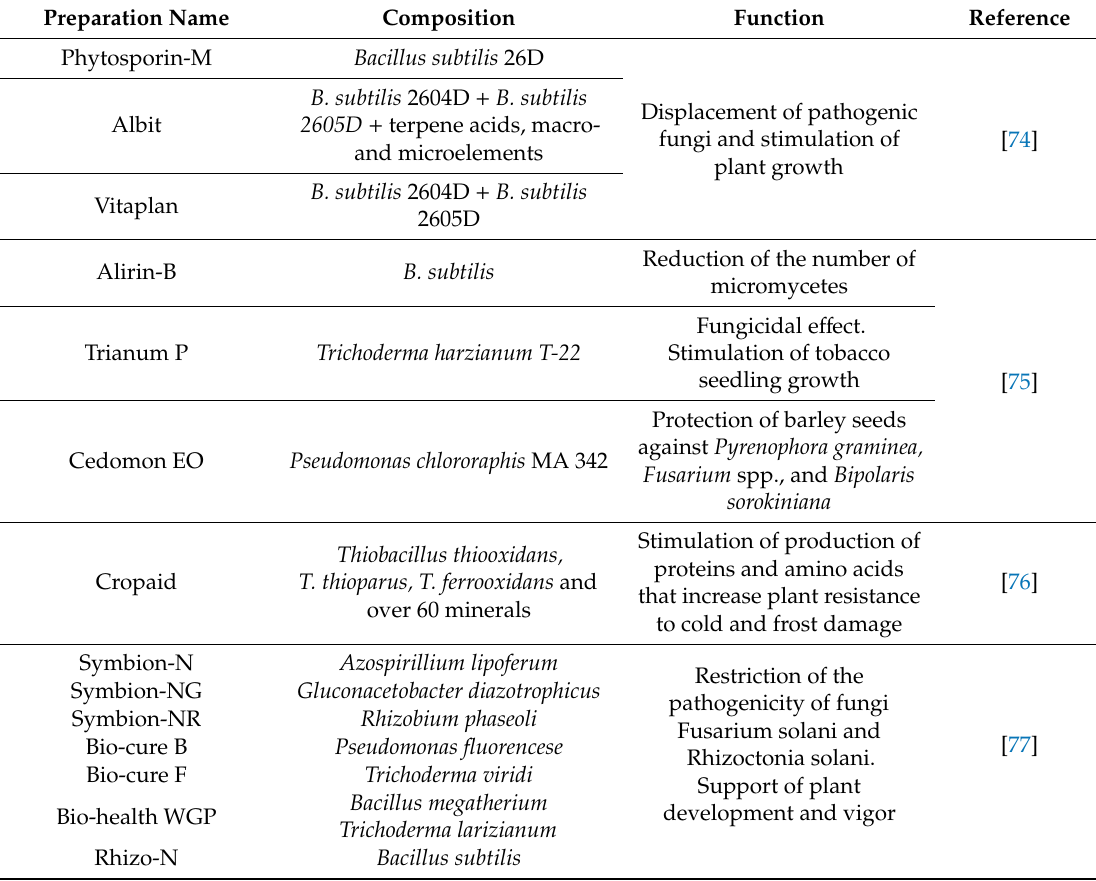
Table 2. Examples of endophytic strains applied for commercial-scale production as biofertilizers and